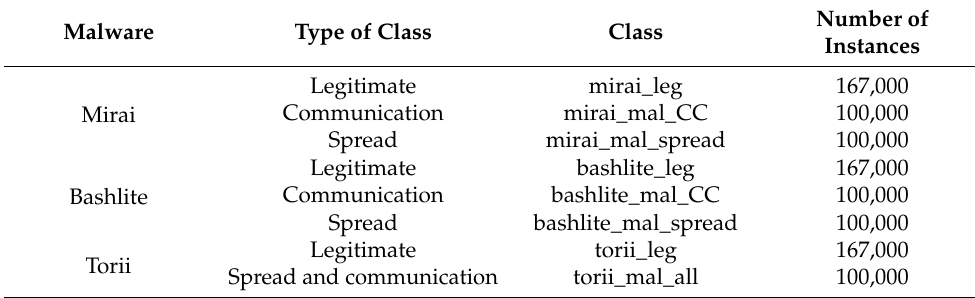
Table 5. The used dataset after undersampling depending on traffic class.